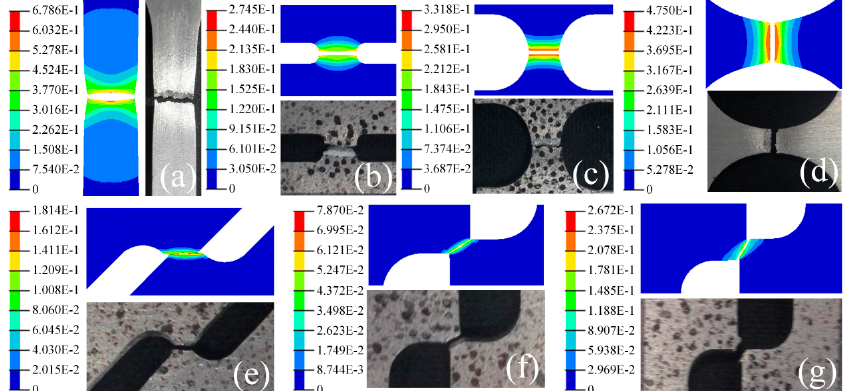
Figure 7. Fracture mode for ADC12 aluminum alloy for ( a ) smooth tensile test, ( b ) notched test for notched radii 4 mm, ( c ) notched test for notched radii 8 mm and ( d ) pure shear test.